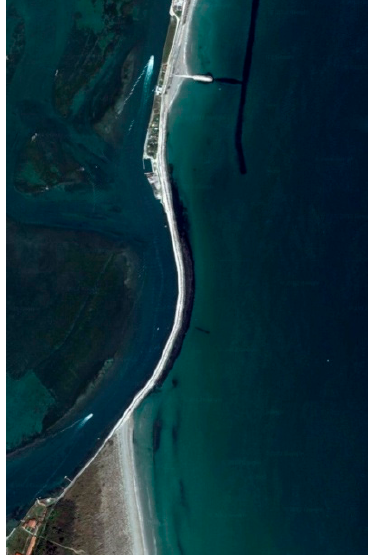
Figure 10. Sandbanks of Pellestrina form Google